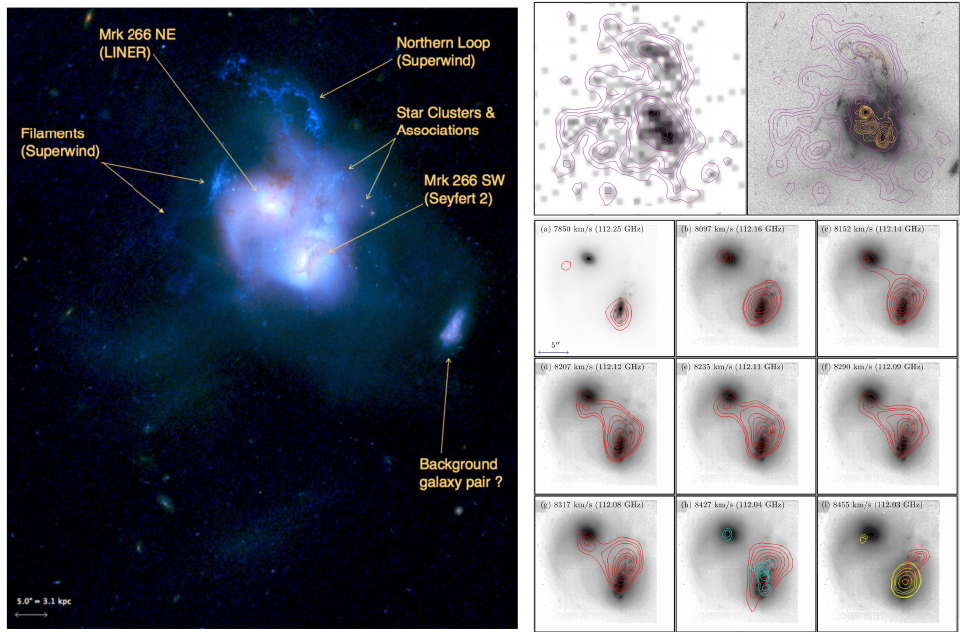
Figure 2. Mrk 266 in multiwavelength light—( Left ) HST composite image showing major structures; ( Right, Top ) soft X-ray contours (magenta contours) compared to the HST F 435 W -band image and VLA radio continuum (orange contours); ( Right, Bottom ) CO (1 − 0) channel maps (red contours), integrated HCN (1 − 0) emission (cyan contours), and integrated HCO + (1 − 0) emission (yellow contours) overlaid on HST 1.6 µ m images. This dual AGN system exhibits an earlier dust blow-out phase and more rapid gas consumption than predicted from simulations, revealing insight into the evolutionary timeline of large-scale superwinds. This study illustrates the complexity of dust and gas kinematics that can only be teased apart with detailed analyses of high-resolution multiwavelength data. Figure adapted from Mazzarella et al. [53]; © AAS, reproduced with permission.